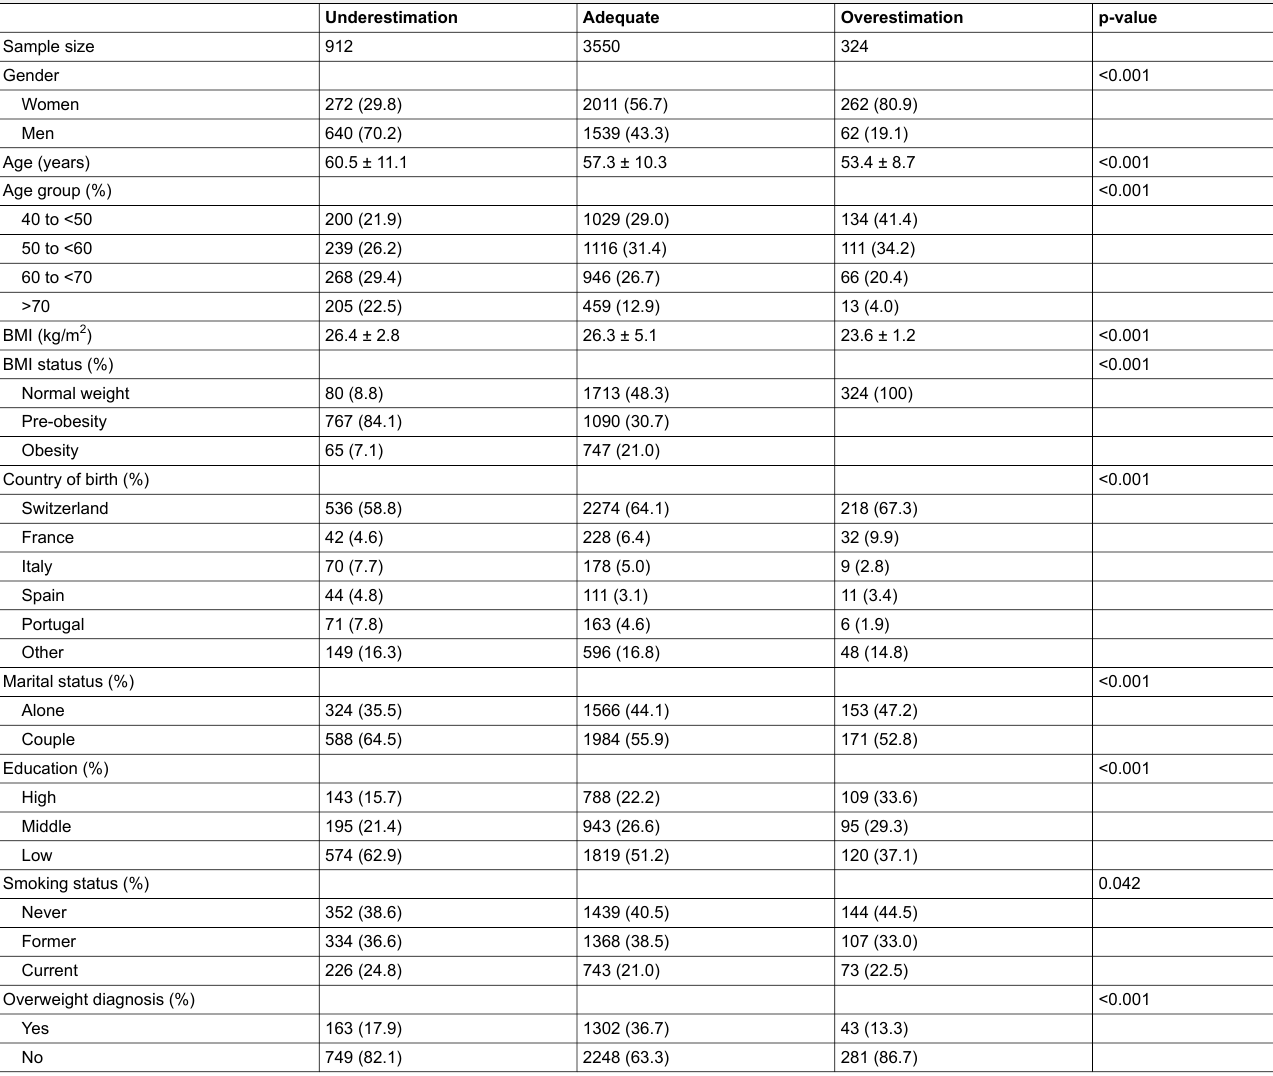
Table 3 : Bivariate analysis of factors associated with weight under- or overestimation, CoLaus study, Lausanne, Switzerland, 2009–2012.